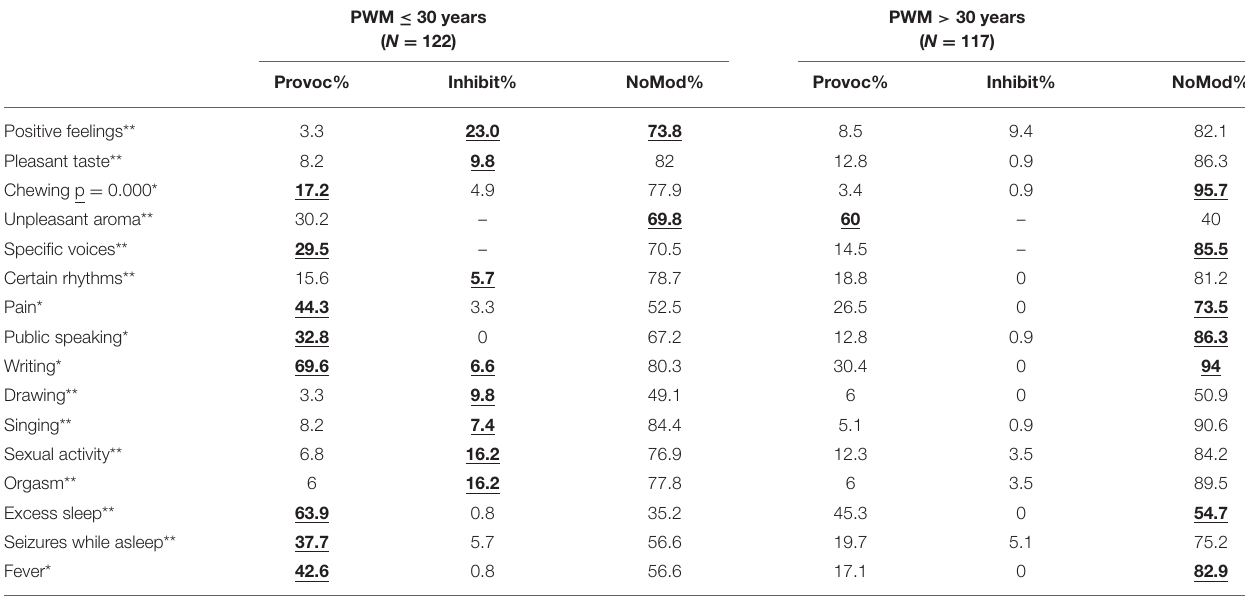
TABLE 3 | Modulatory factors with significant difference between two age groups in